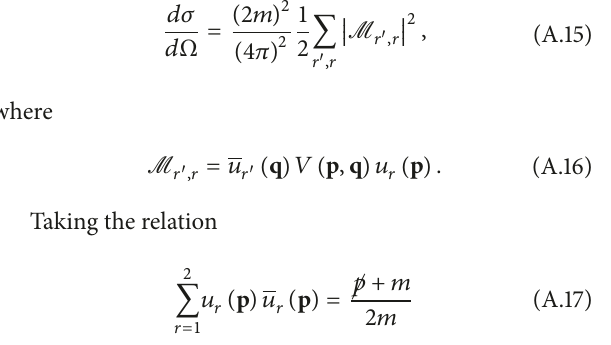
Figure 5: Diagram for the interaction between a photon and an external weak gravitational